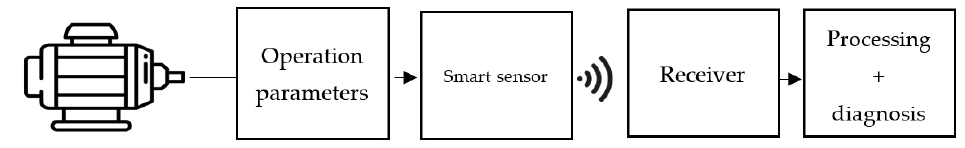
Figure 2. Electric motor monitoring via smart sensor diagram.